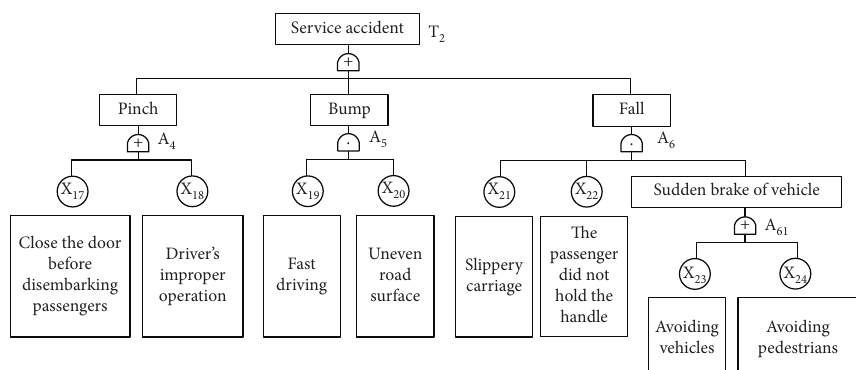
Figure 3: Fault tree of service accidents in urban bus